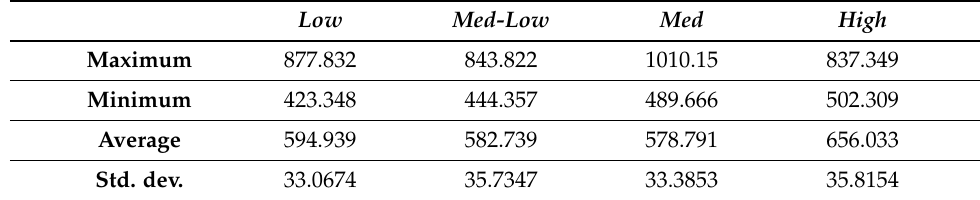
Table 6. Dispersion measures for cost 2